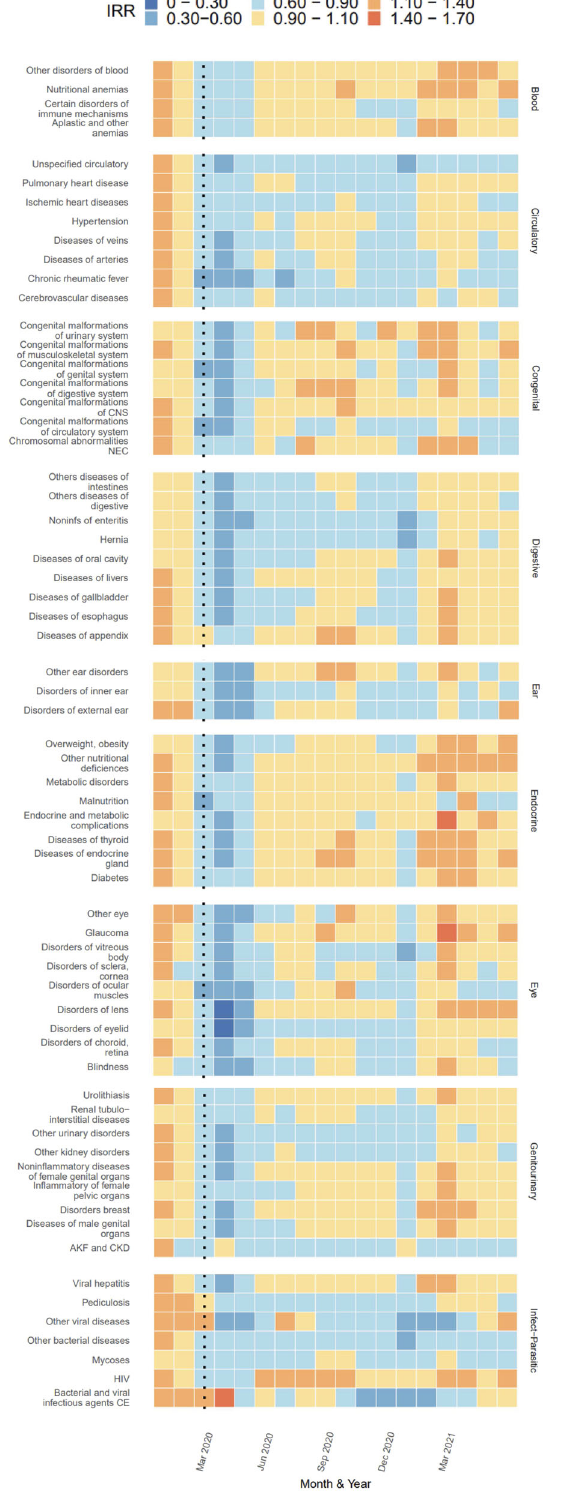
Fig. 4 | Estimated Incidence Rate Ratio (IRR) per subchapter and month from cluster C groupedaccording to diagnostic chapters(Mental, Musculoskeletal, Neoplasms, Nervous System, Perinatal, Pregnancy, Respiratory, Skin, and Symptoms), Jan 2020 to Jun 2021. Note: Estimates of IRR made by dividing observed by predicted cases per diagnosis per month. Monthly predictions made using trends in previous years data after adjusting for seasonality and time trends with an offset for estimated active